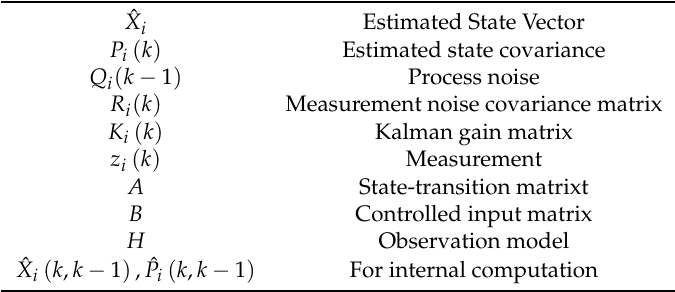
Table 1. Variables used in the LKF algorithm.